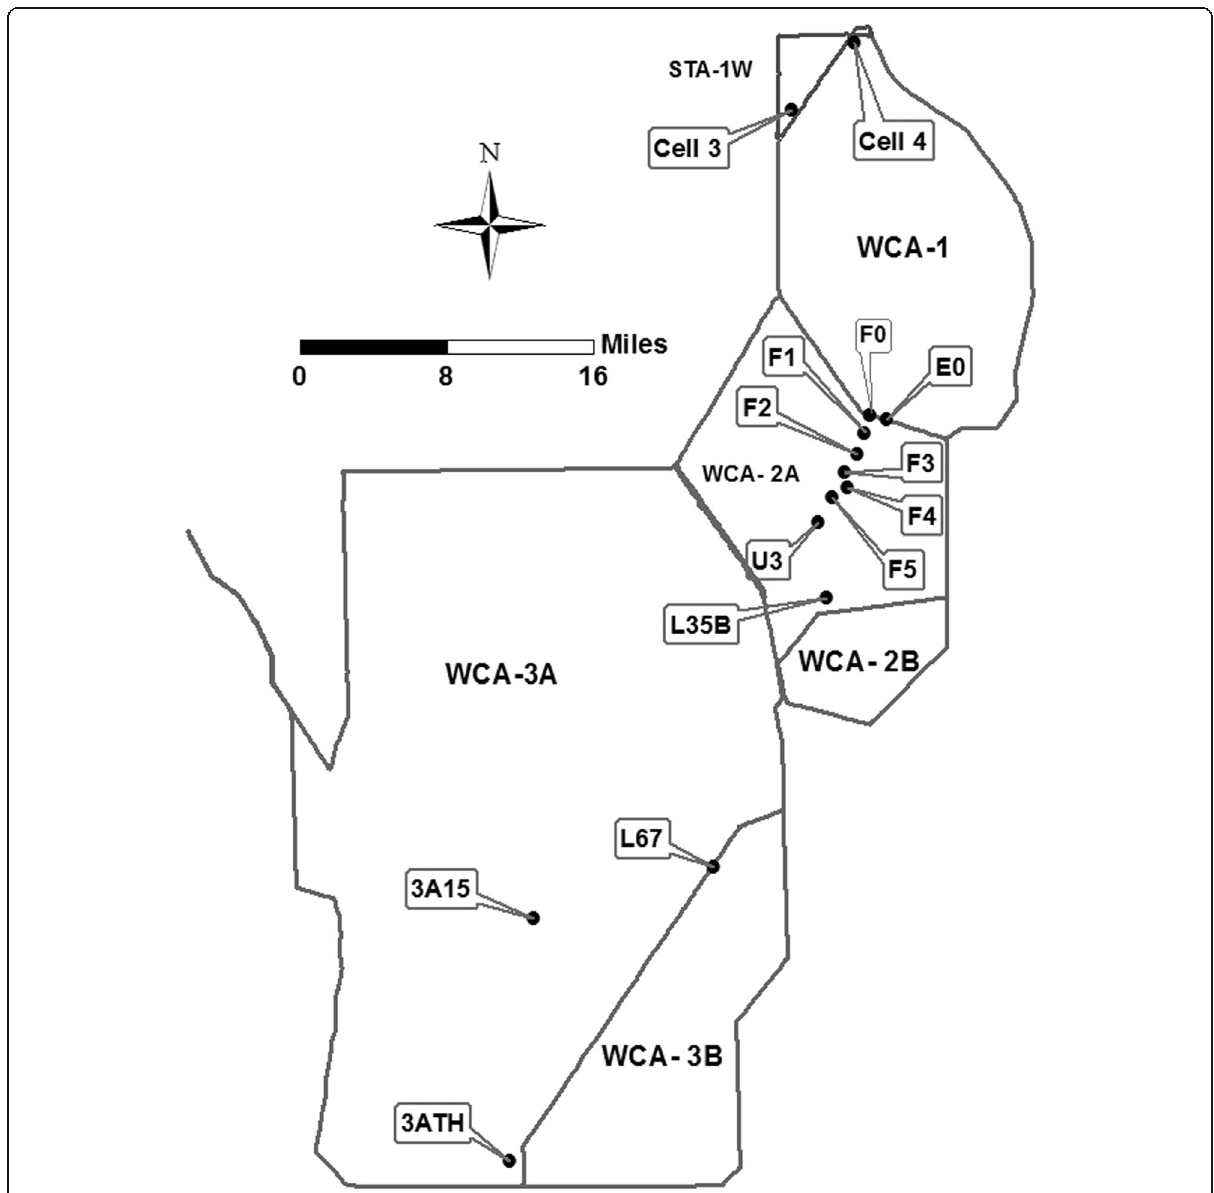
Fig. 1 Map showing sampling sites in Stormwater Management Area 1 West (STA-1W) and Water Conservation Areas (WCAs) in